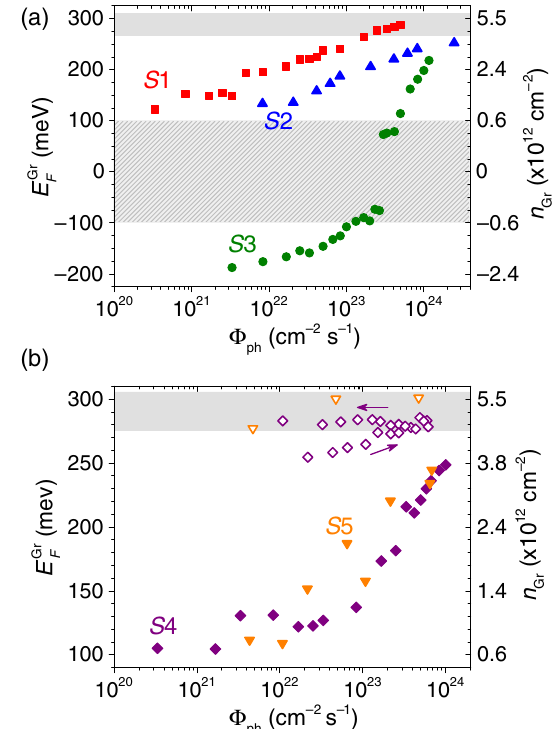
FIG. 5. (a) Fermi energy E Gr F (left) and doping level n (right) Gr in graphene as a function of the incident photon flux Φ . ph Measurements on three selected Gr = MoSe 2 samples (denoted S 1 , S S 2 , and 3 ) are represented with different symbols. The data shown in Figs. 1 – 4 are from S 1 . The hatched region denotes the range of E Gr F close to the charge neutrality point where there is an uncertainty on the sign and on the exact value of E Gr F . The gray rectangle illustrates the saturation value of E Gr F . (b) E Gr F (left) and n (right) as a function of Φ obtained under ambient conditions Gr ph (filled symbols) and in vacuum (open symbols) at the same point of a Gr = MoSe 2 = SiO 2 and a MoSe 2 = Gr = SiO 2 heterostructure, denoted S 4 and S 5 , respectively. Measurements under vacuum in S Φ is swept forward for the first time and then 4 are shown as ph backward (see